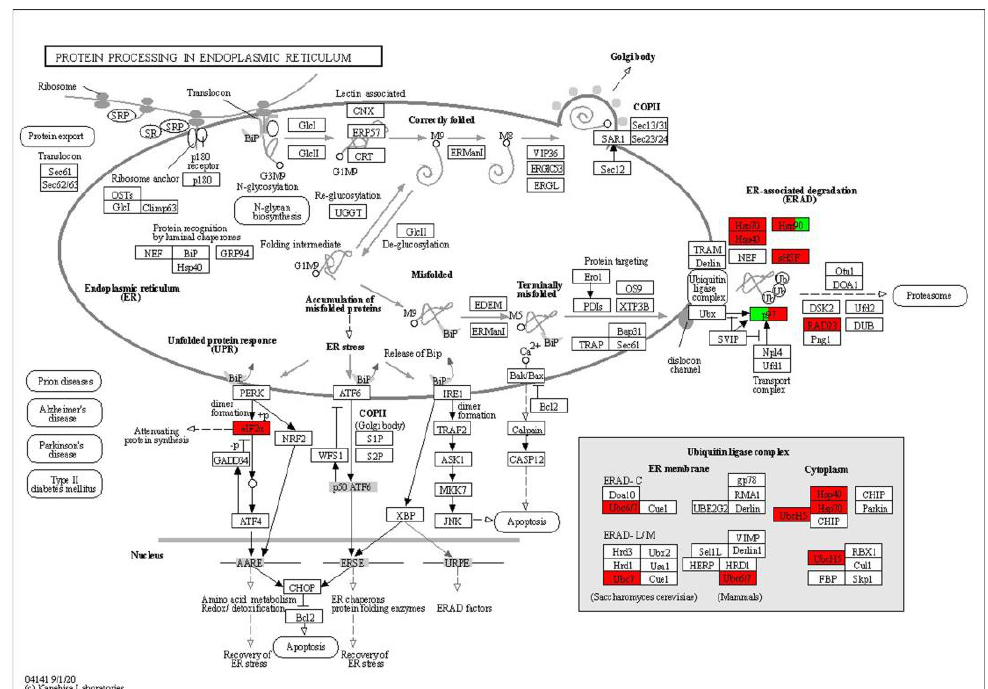
Figure 7. Ubiquitinated proteins of maize in the ER protein process pathway. Ubiquitinated proteins are highlighted in red or green: red indicates up−regulated Kub proteins, while green indicates down−regulated Kub proteins.